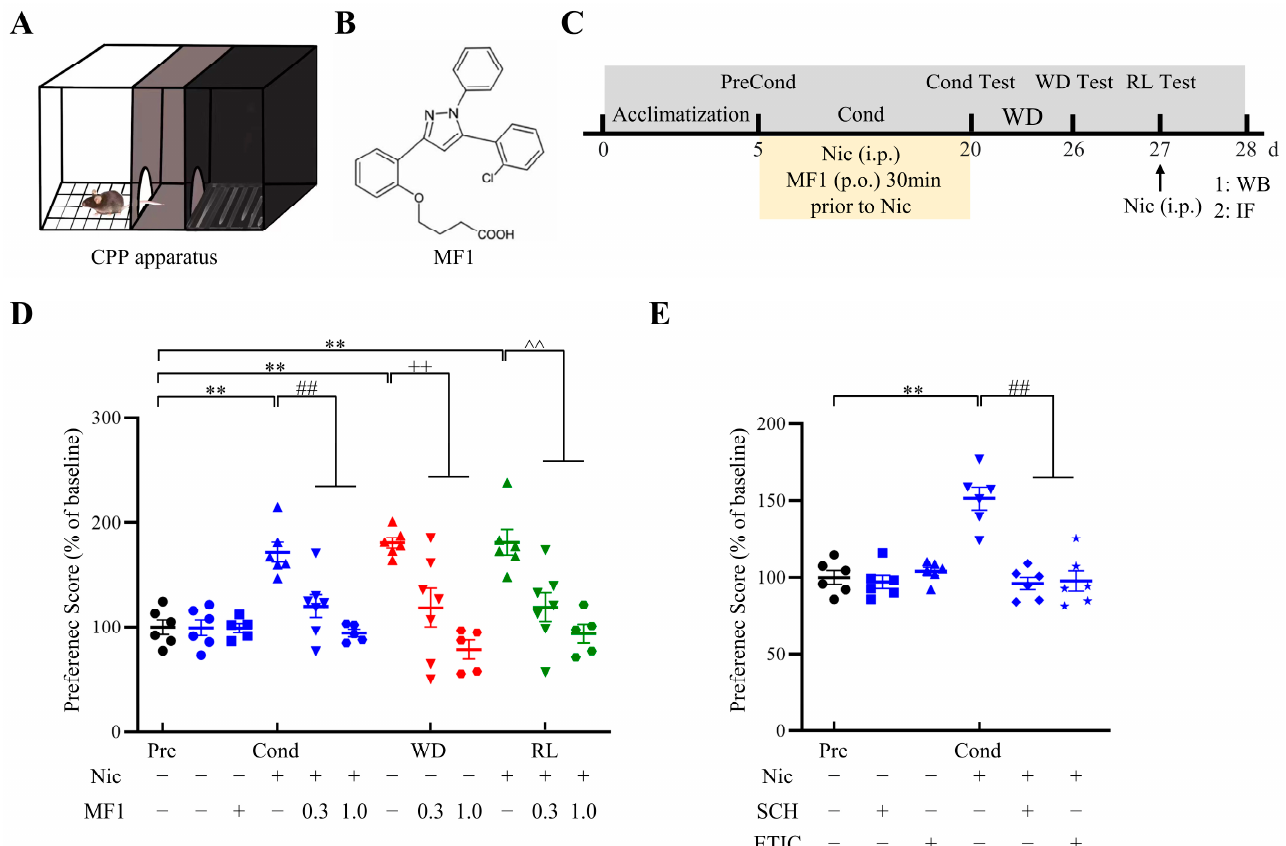
Figure 1. Experimental schedule and CPP tasks. ( A ) Graphical display of the CPP apparatus used in the present study. ( B ) Chemical structure of the FABP3 inhibitor, MF1. ( C ) Experimental procedure for CPP tasks and MF1 treatment. ( D ) Mice that received MF1 pretreatment showed signi fi cantly lower CPP scores in conditioning, withdrawal, and relapse phases. A 1.0 mg/kg dose showed more potent e ff ects relative to a 0.3 mg/kg dose ( n = 5–7 per group). ** p < 0.01 vs. preconditioning vehicle-treated group; ## p < 0.01 vs. conditioning nicotine-treated group; ++ p < 0.01 vs. nicotine-treated group following withdrawal; ^^ p < 0.01 vs. nicotine-treated group following relapse. ( E ) Pretreatment with SCH23390 or eticlopride completely blocked nicotine-induced CPP in mice ( n = 6 per group). ** p < 0.01 vs. preconditioning vehicle-treated group; ## p < 0.01 vs. conditioning nicotine-treated group. Precond, preconditioning test; Cond, conditioning; WD, withdrawal; RL, relapse; Nic, nicotine; WB, western blo tt ing; IF, immuno fl uorescence staining; SCH, SCH23390 hydrochloride; ETIC, eticlopride hydrochloride. Error bars represent SEMs. The individual values in the CPP tasks are represented by data symbols, including solid dots, squares, triangles, inverted triangles, diamonds, and star pentagons, which are color-coded using black, blue, red, and green to distinguish between phases.